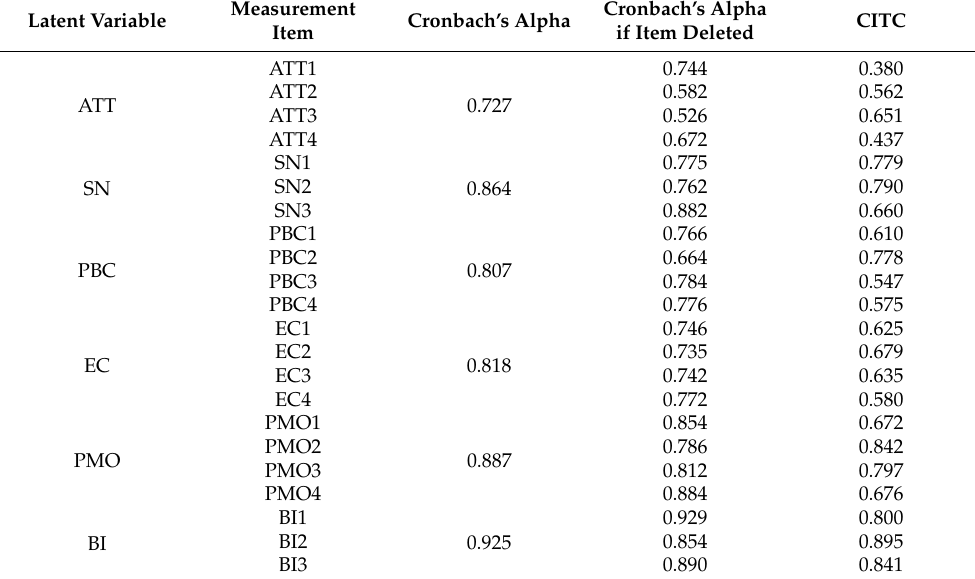
Table 4. Reliability test